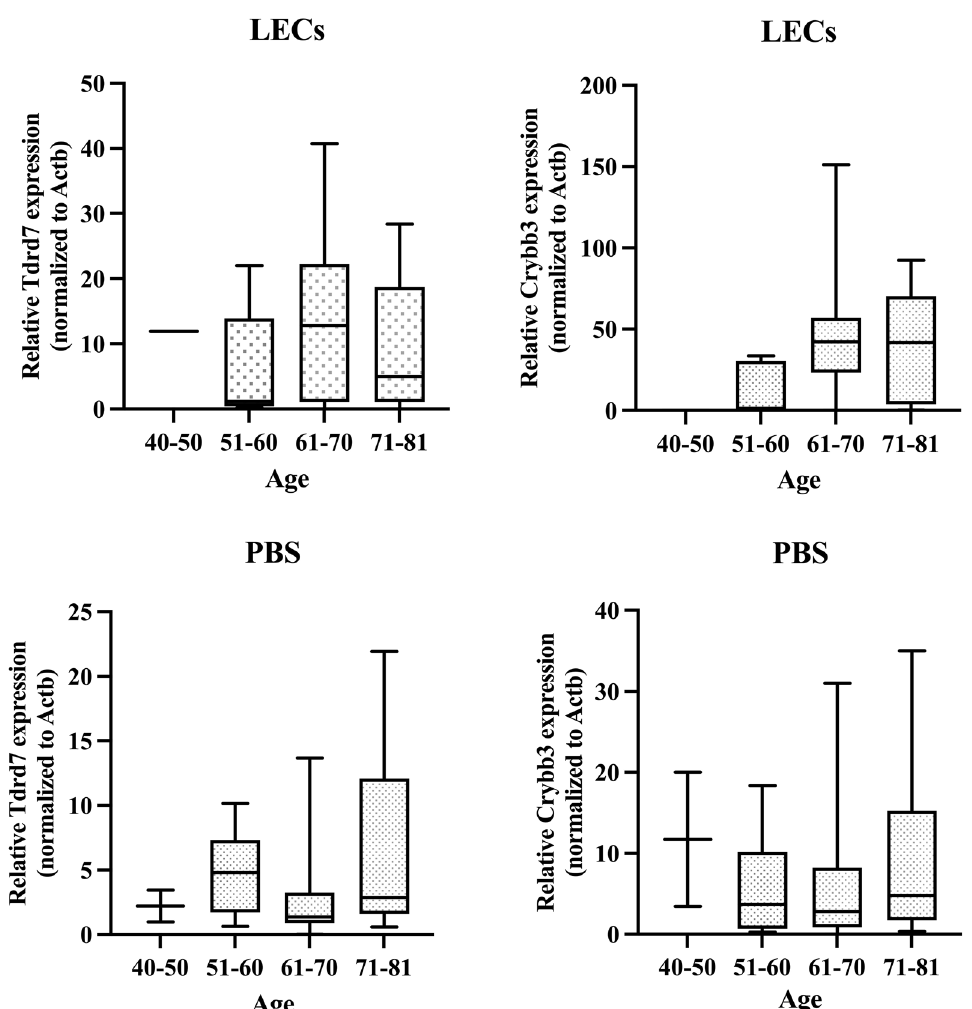
Fig. 5 Comparison of expression levels of TDRD7 and CRYBB3 according to age groups. LECs Lens Epithelial Cells, PBS Peripheral Blood